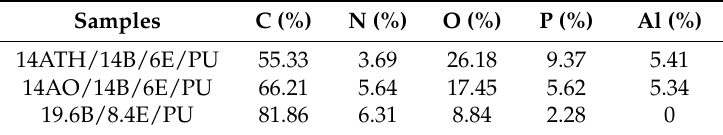
Table 3. Elemental contents of residues from flame retardant RPUFs.